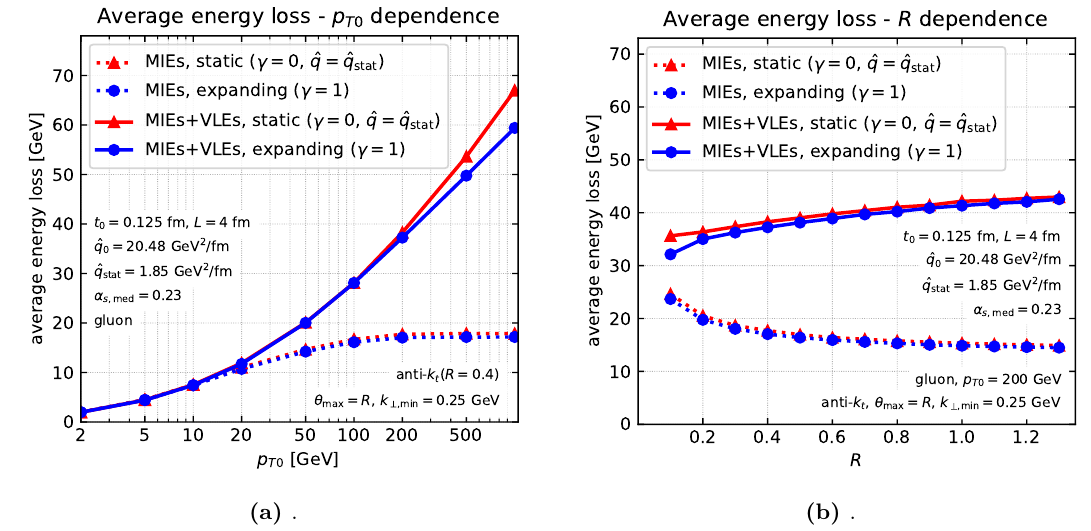
Figure 3. Our MC results for the average energy loss by a gluon-initiated jet are displayed as a function of the initial energy p T 0 of the leading parton (left) and the jet radius R (right), for two scenarios for the jet evolution: jets with MIEs only (dotted lines) and full showers with both MIEs and VLEs (plain lines). For each scenario, we compare the case of an expanding medium (blue) with the equivalent static one